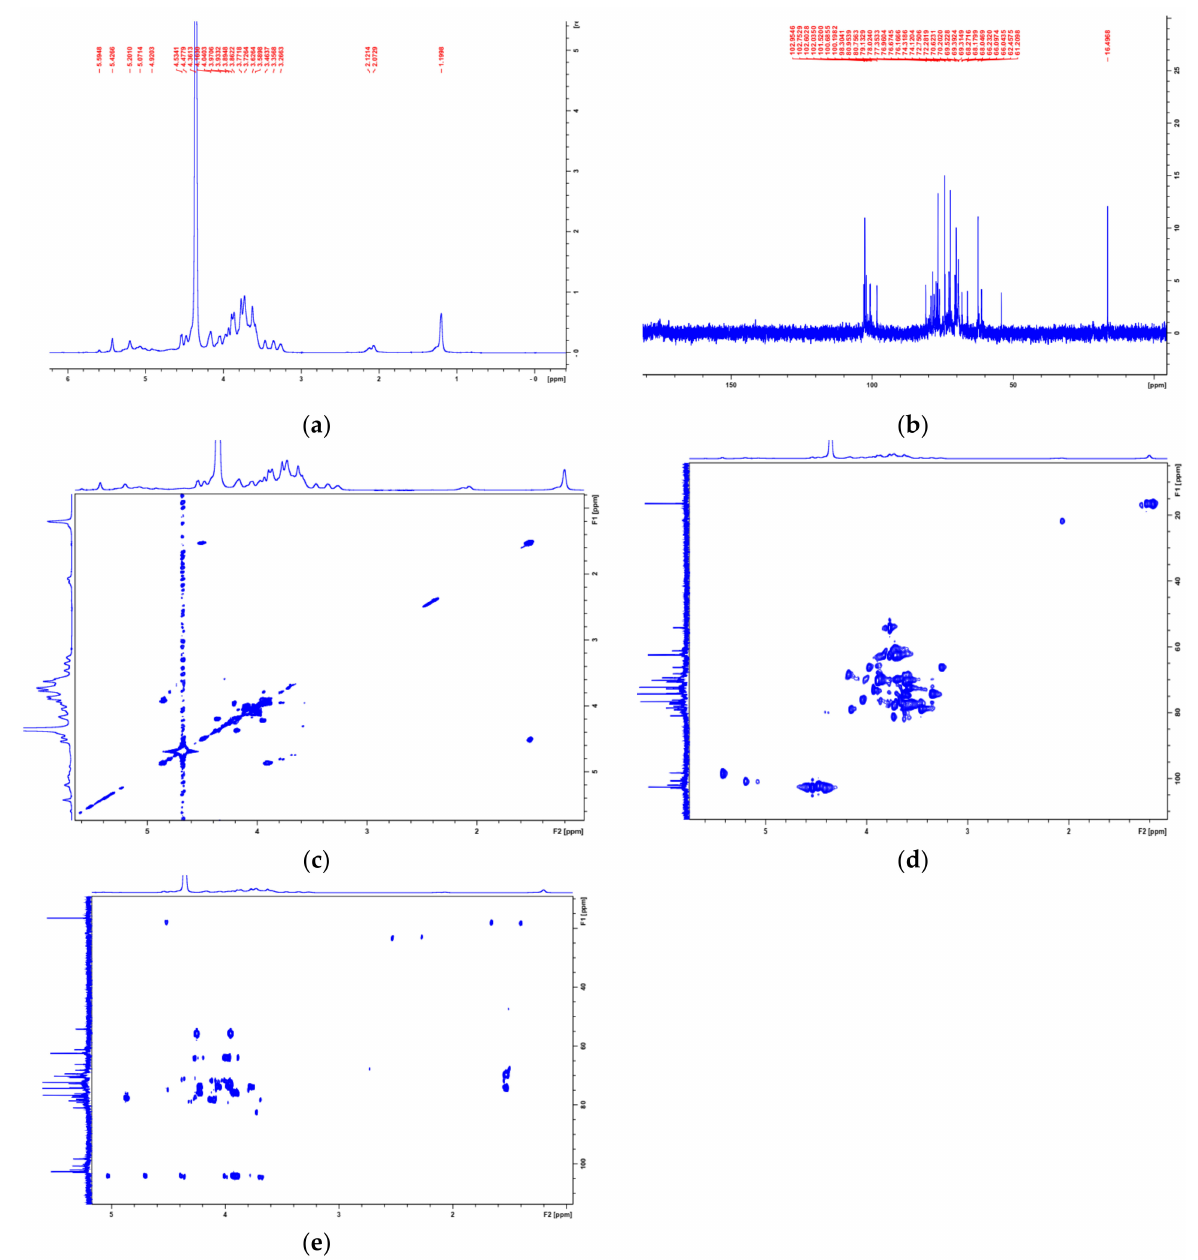
Figure 5. NMR spectra of PAP-3. (( a ): 1 H NMR; ( b ): 13 C NMR; ( c ): 1 H/ 1 H COSY; ( d ): HSQC; ( e ): HMBC).